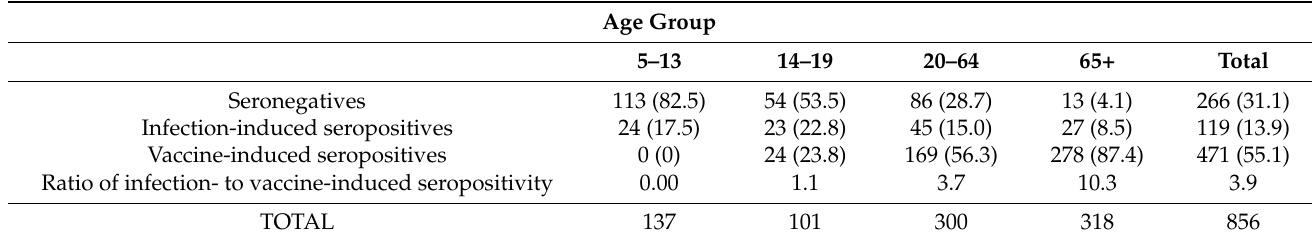
Table 2. Seronegative, infection-induced seropositive, and vaccine-induced seropositive participants for SARS-CoV-2 antibodies by age group at the third follow-up (June–July 2021), expressed as numbers (percentages), if not otherwise specified.